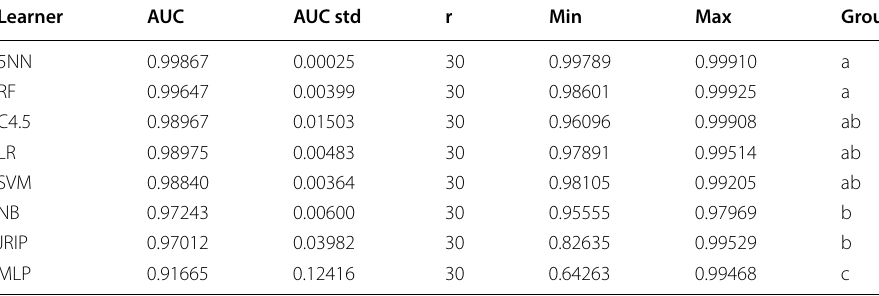
Table 4 Tukey’s HSD learner